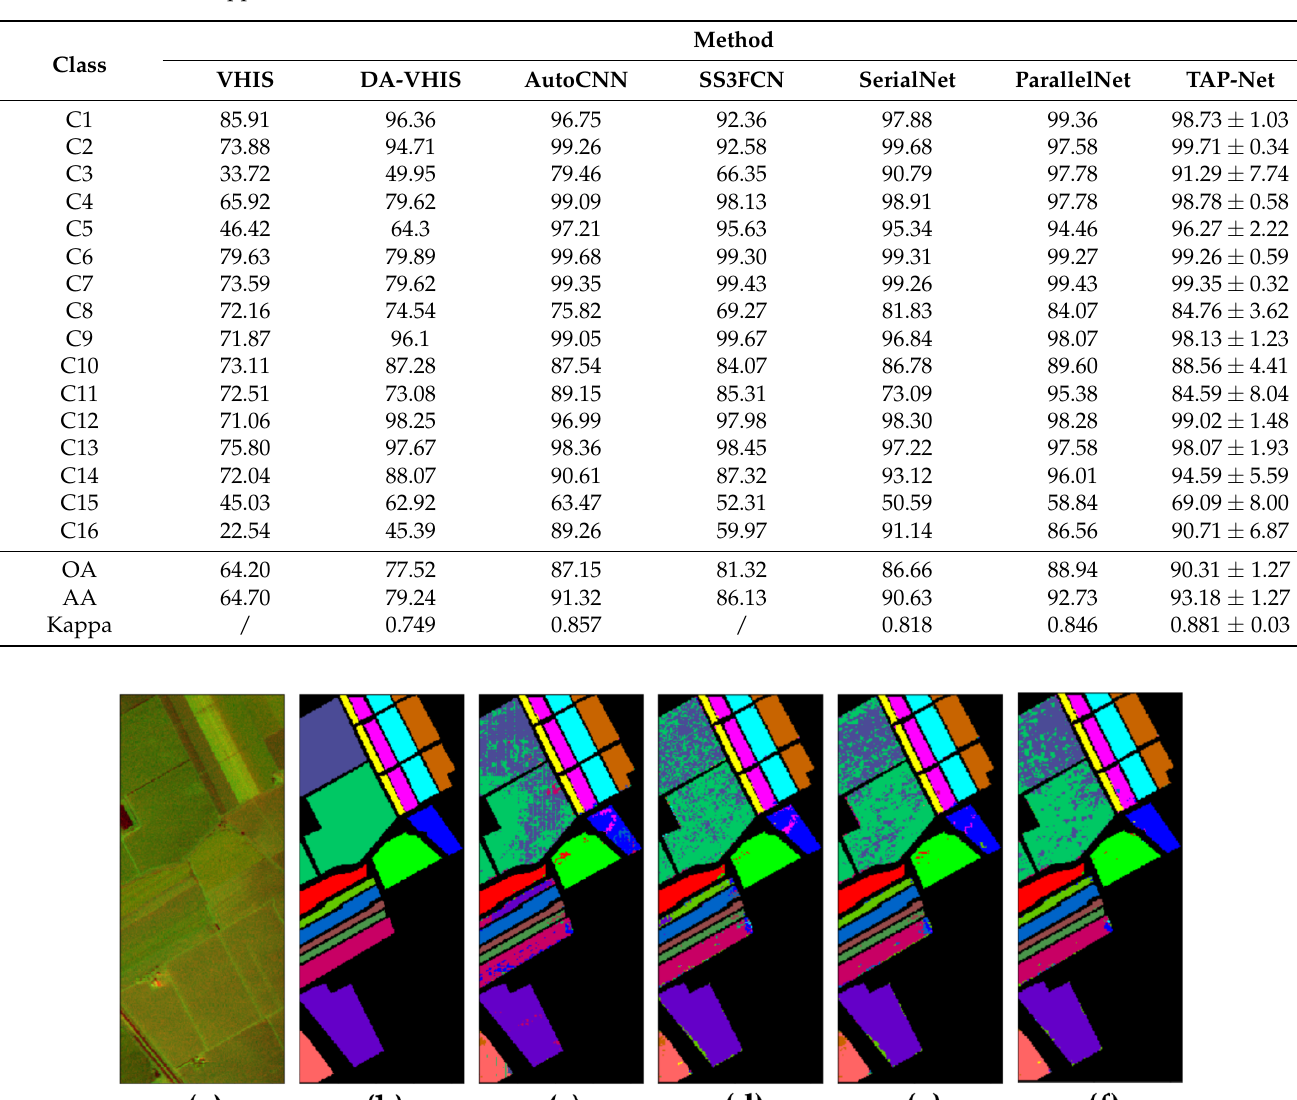
Table 5. Classification results for the Salinas Valley dataset, including per-class, overall (OA), and average (AA) accuracy (in %), and the Kappa scores.